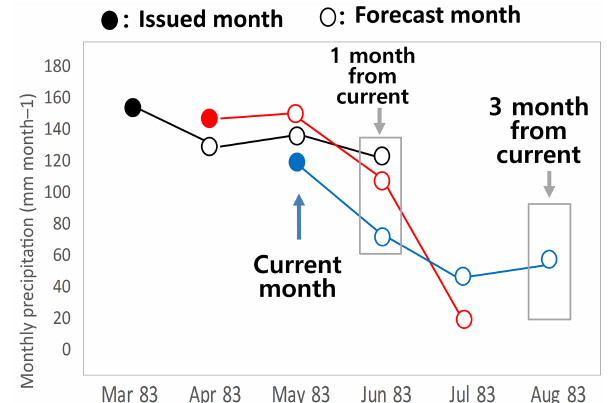
Figure 4. Description of the monthly prediction approach and use of different amounts of prediction data according to lead time.